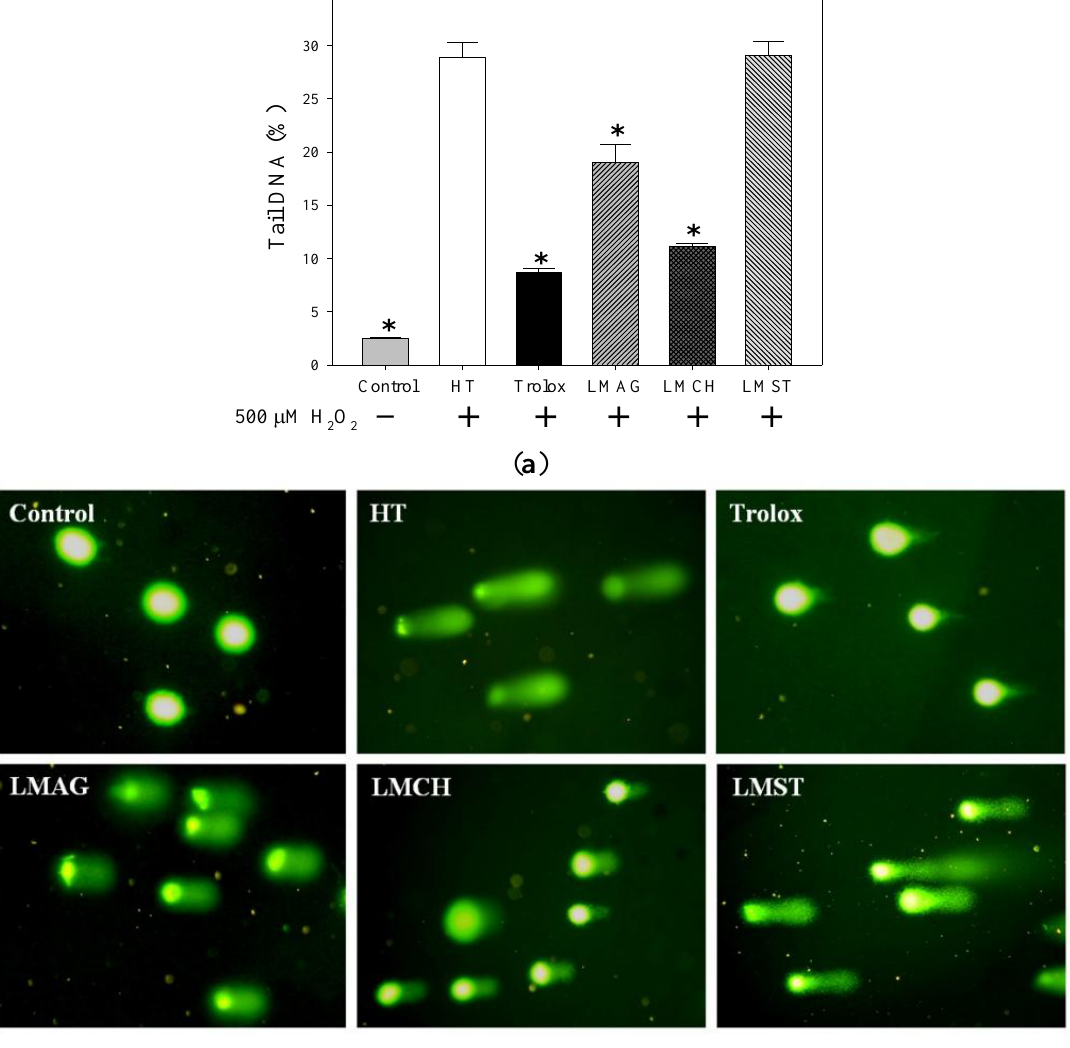
5. The effects of 1000 μg/mL low-molecular-weight agar (LMAG), low-molecular-weight chitosan (LMCH), low-molecular-weight starch (LMST) and trolox on DNA damage in Hs68 cells after 30 min treatment with 500 μM H O . ( a ) Tail 2 2 DNA (%) was calculated from the measurement of 50 cells per slide by Comet-Score image analysis. Data are expressed as mean values ± S.D. of three slides. * p < 0.05 (treatment vs . HT); HT = H O treatment; ( b ) Representative Comet images 2 2 (SYBR ® Green I) of individual Hs68 cells, acquired with a fluorescence microscope equipped with a digital